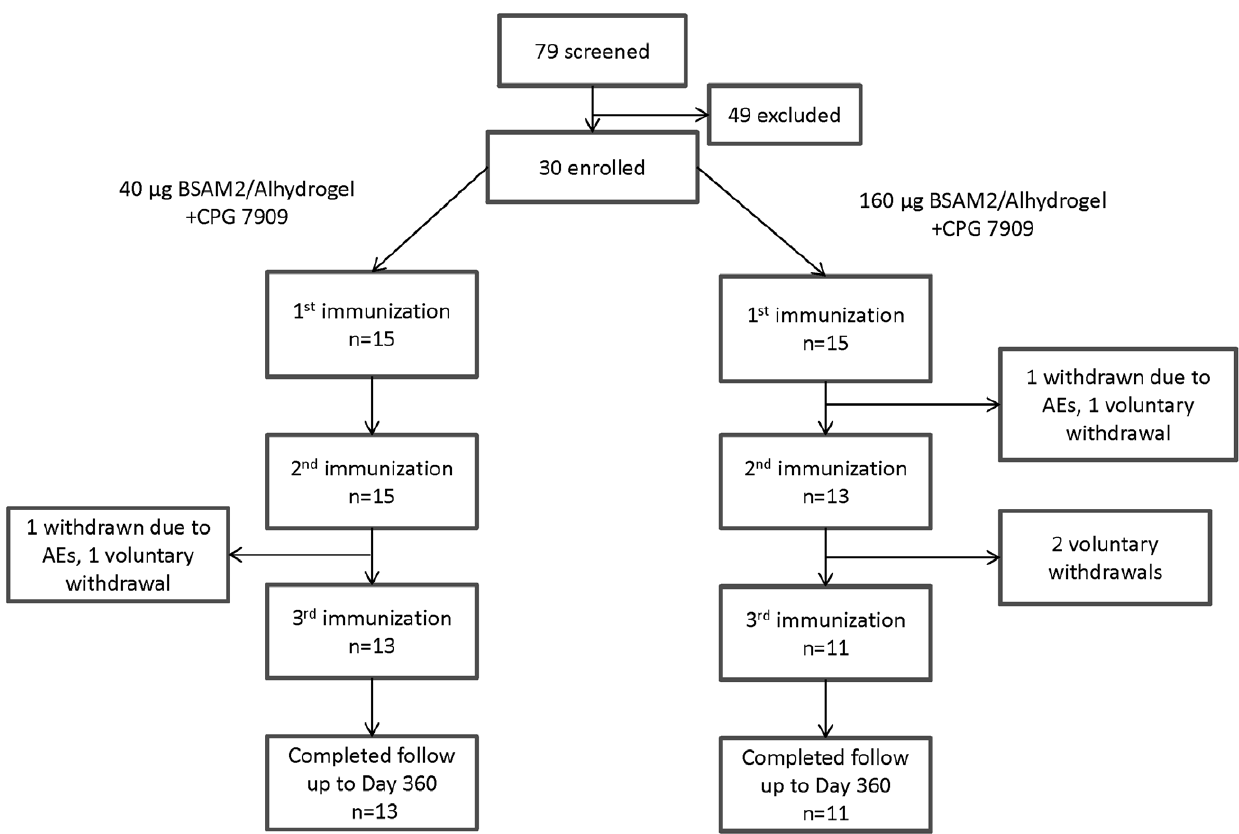
Figure 1. Participants flow sheet. Thirty (30) participants were enrolled, 24 participants completed vaccinations, and 24 completed follow-up to Day 360.